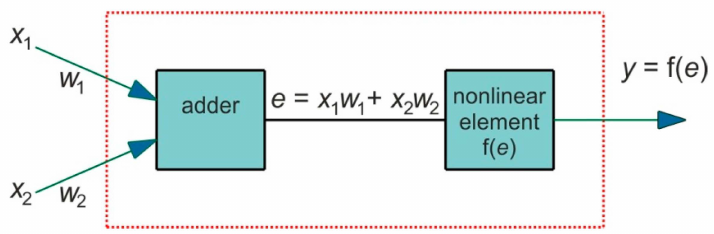
Figure 6. Structure of an individual